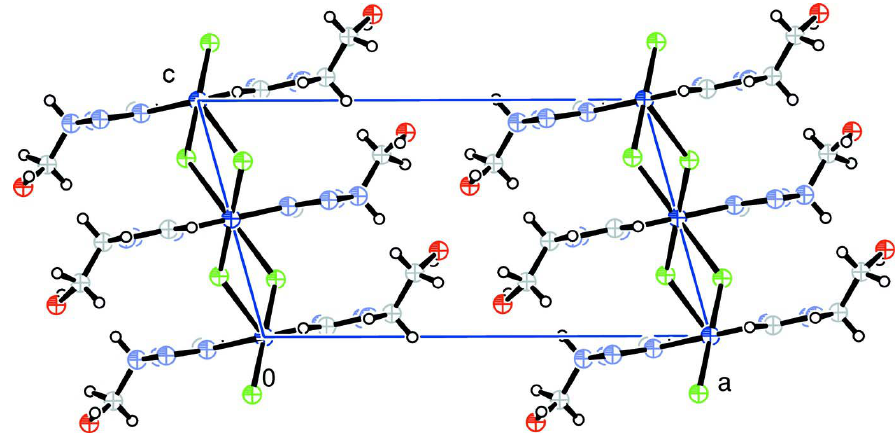
Figure 2 Layered structure of (I), viewed along the b axis. Disordered 2-hydroxyethyl substituent is shown only in position with occupancy factor of 0.562 (12).